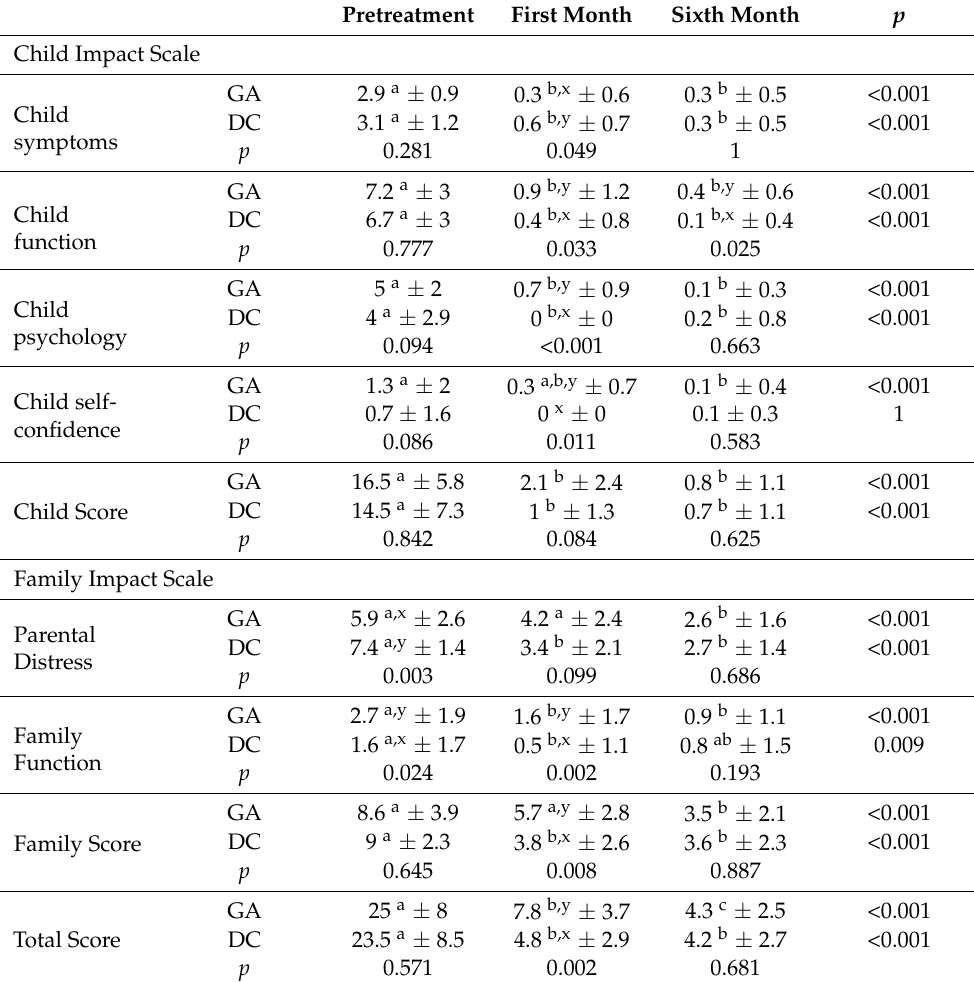
Table 4. Distribution of ECOHIS scores of the study groups in the first and sixth months (Mean ± Standard